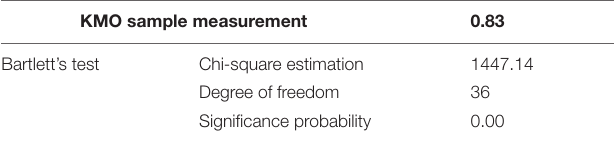
TABLE 2 | Patient participation and KMO’s and Bartlett’s test.